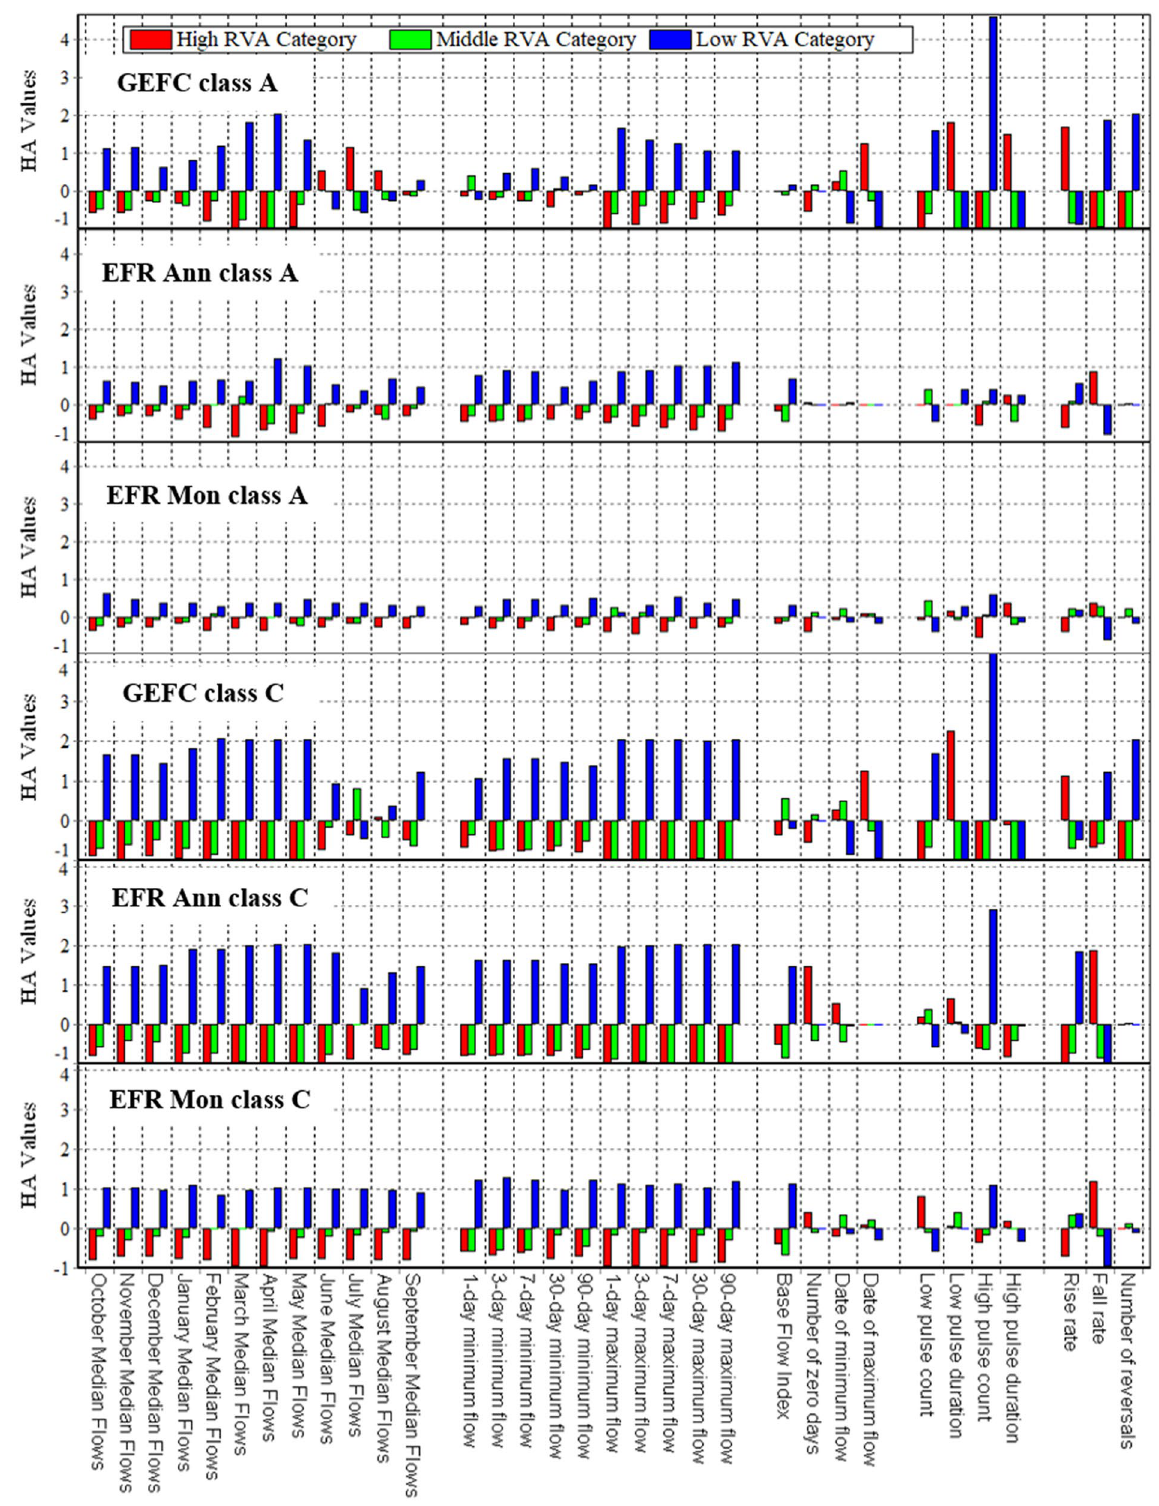
Figure 8. HA values using the RVA method for EFR allocations in two A and C EMCs with GEFC, annual, and monthly approaches at the Tapik Station, Nazlu